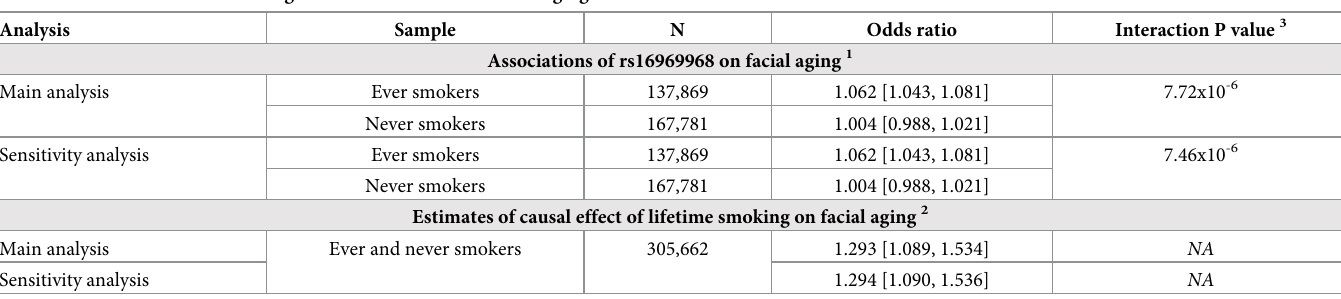
Table 1. Results of associations of genetic instruments with facial aging